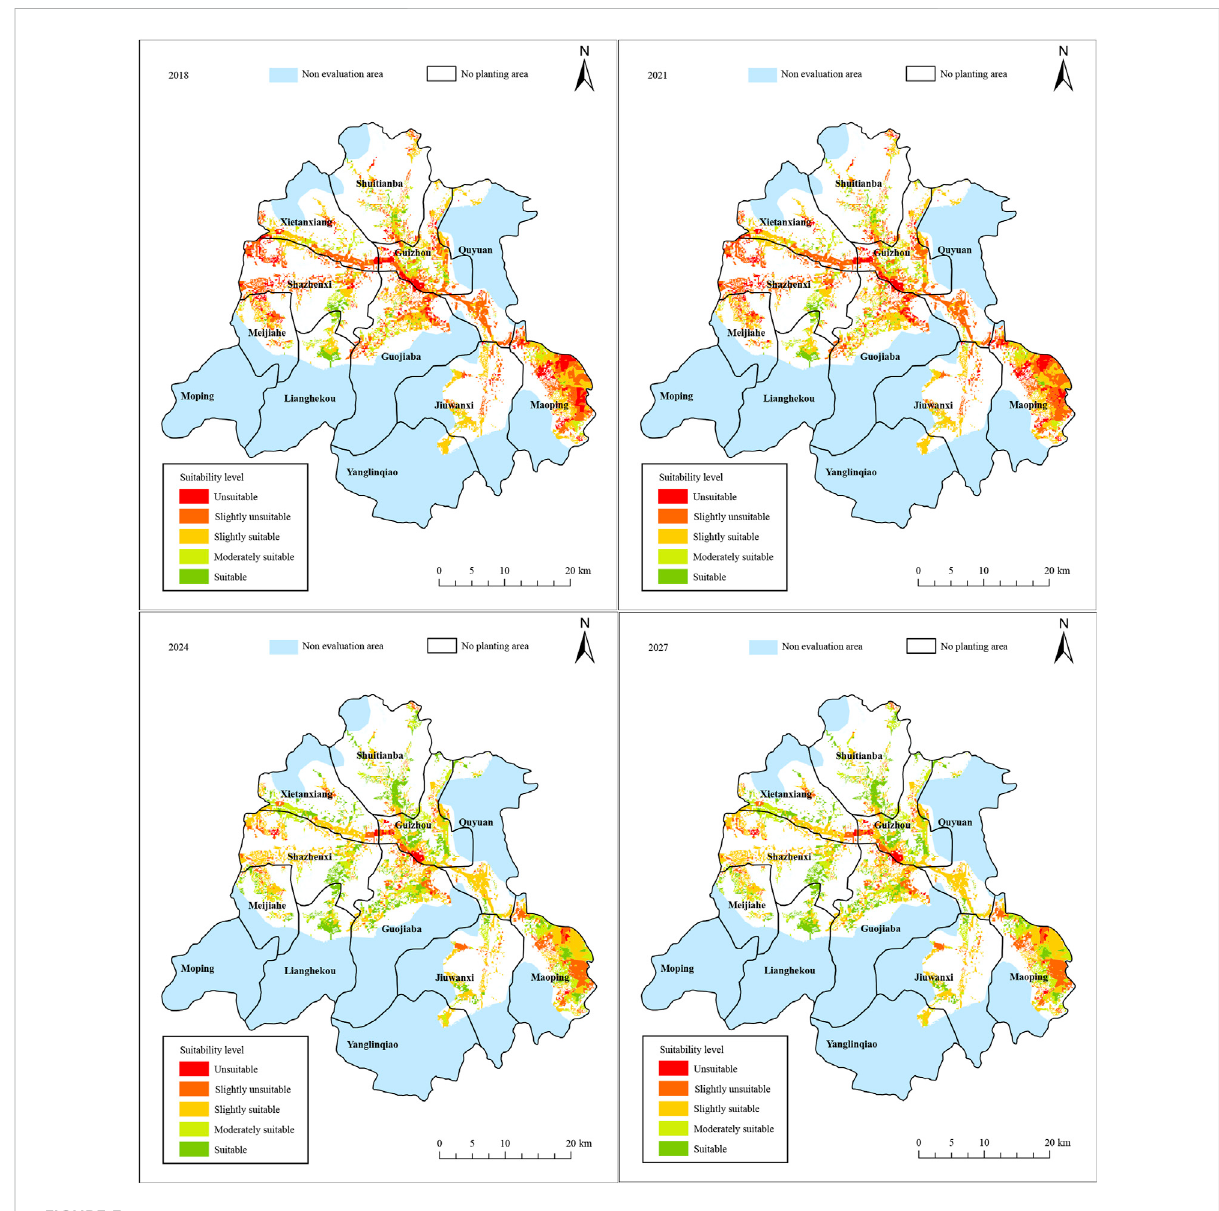
FIGURE 3 Prediction results of environmental suitability for citrus cultivation in Zigui